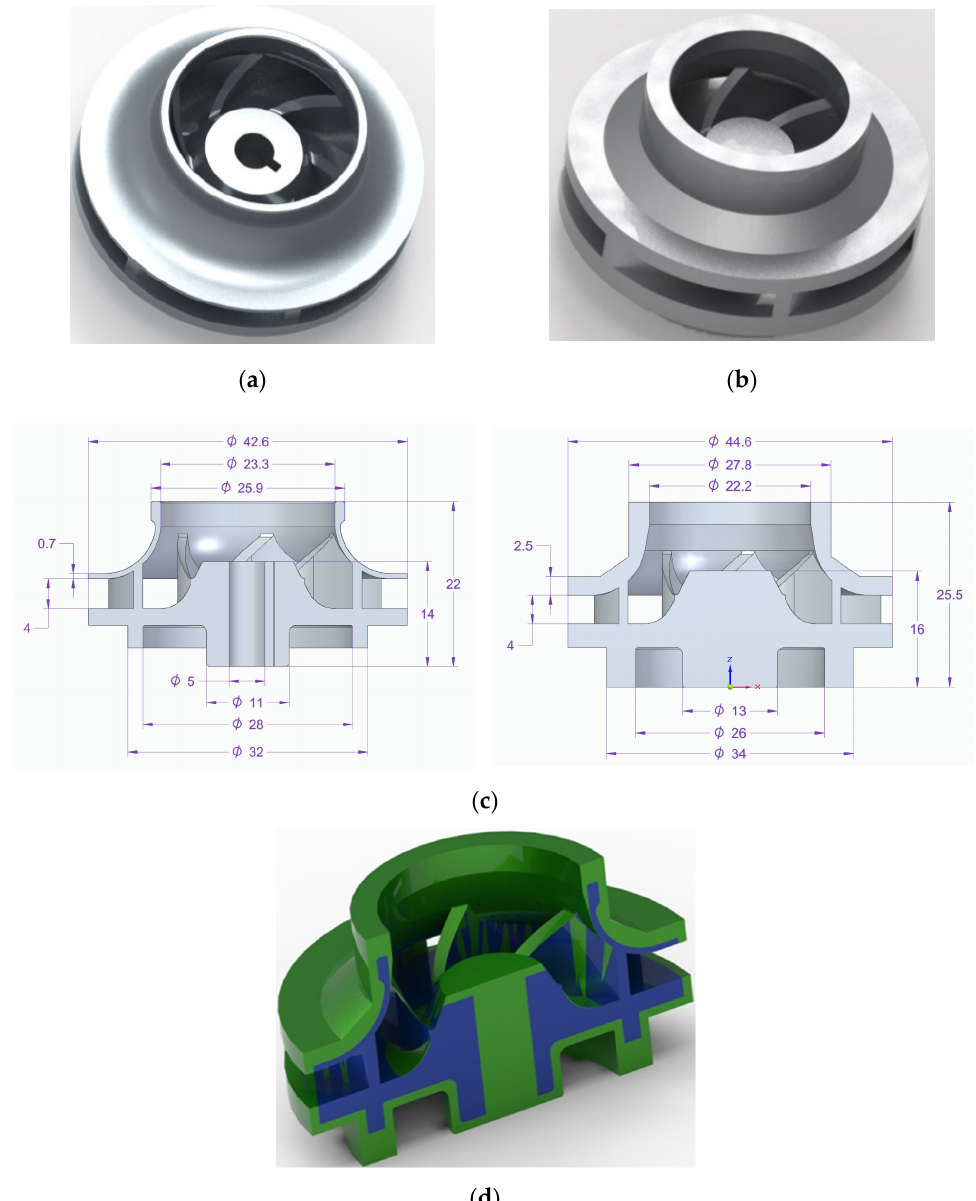
Figure 2. Representation of the initial closed impeller model (blue) and offset model (green) for the additive manufacturing (AM) process: ( a ) isometric view of the closed impeller model; ( b ) isometric view of the closed impeller model with offset material; ( c ) section view representation and dimensions of the two closed impellers (mm); ( d ) overlapping representation of the two impellers.